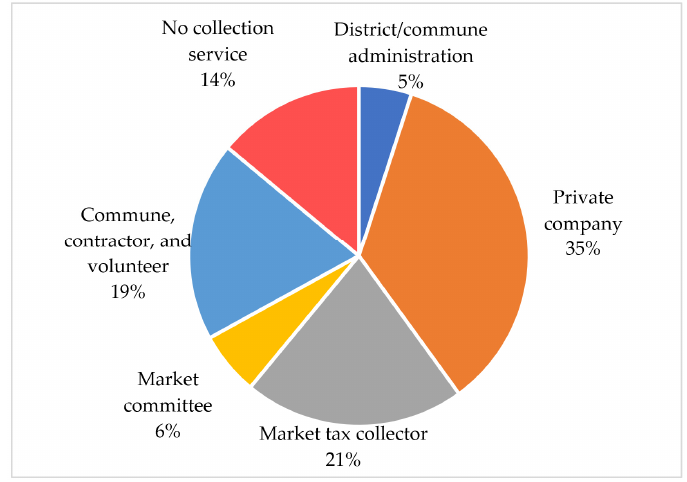
Figure 5. MSW collection service provision by different actors. Adapted from [27].